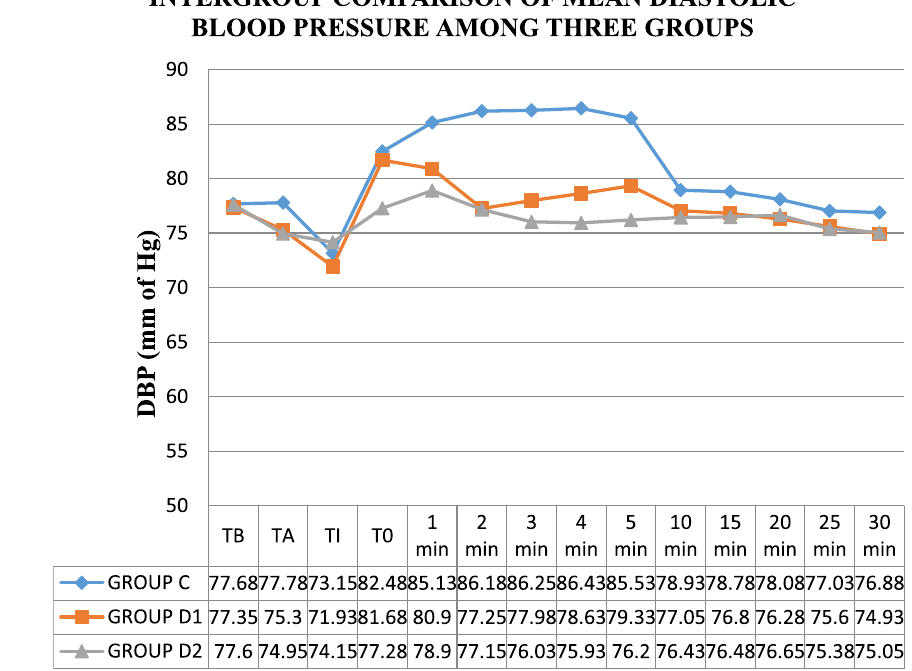
Fig. 4 Comparison of mean DBP among three